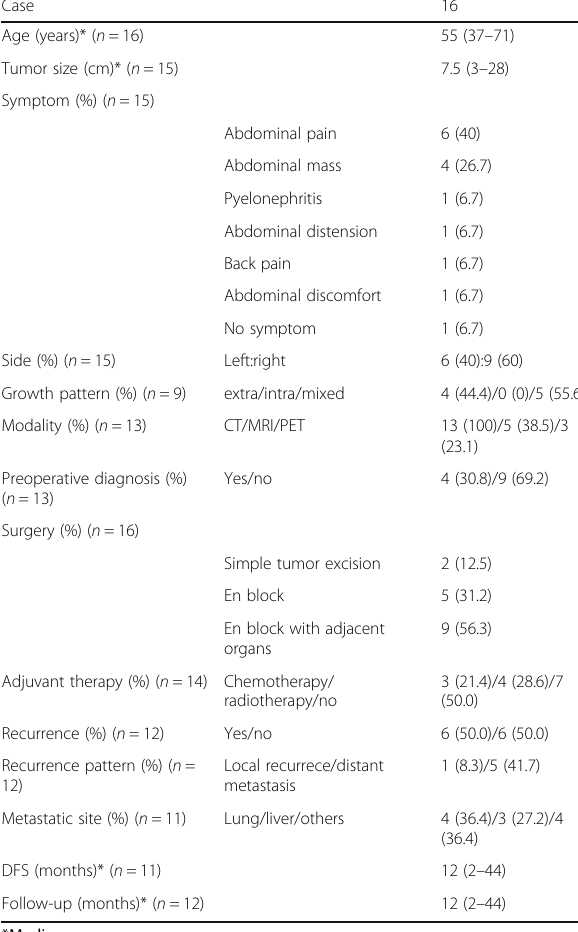
Table 1 Summary of leiomyosarcoma originated from the ovarian vein